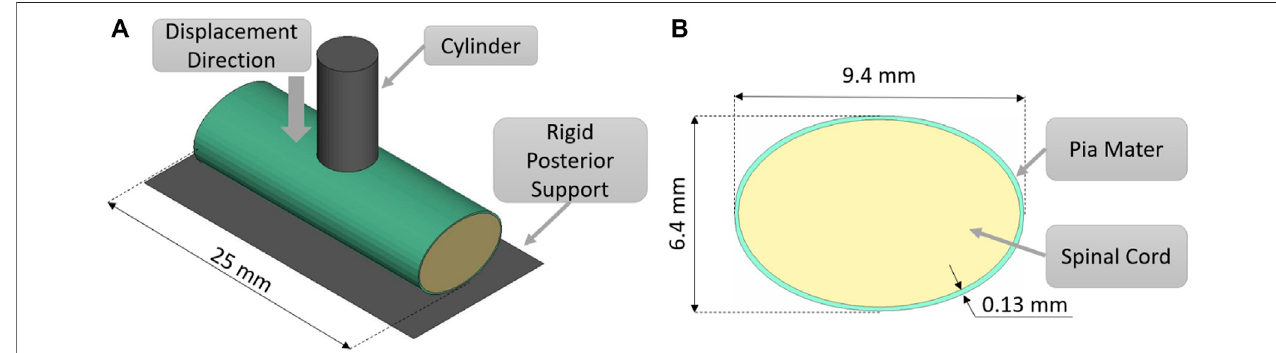
FIGURE 1 | (A) Indentation test simulation setup, isometric view. (B) Transverse cross-sectional view of the spinal cord-pia mater complex with the dimensions used in the indentation